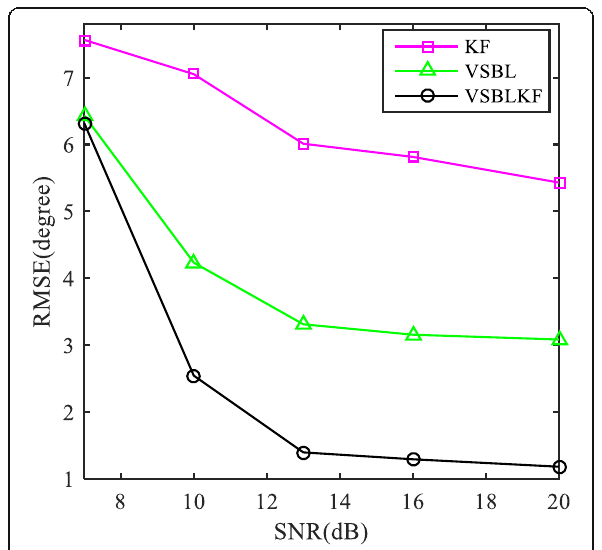
Fig. 11 Estimated elevation as a function of time